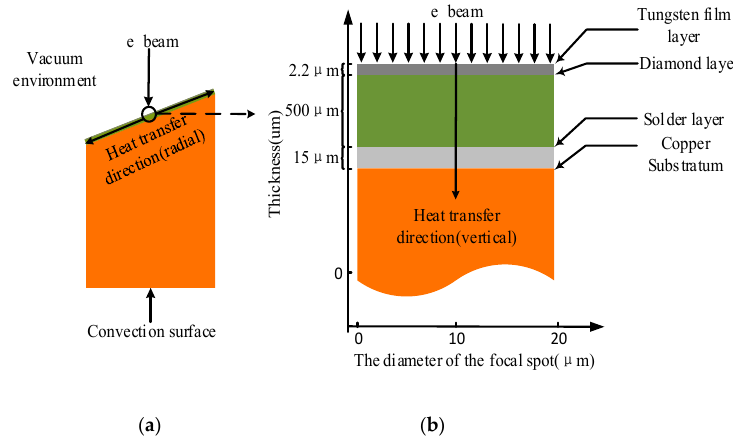
Figure 3. Two-dimensional unsteady heat transfer model of the composite anode. ( a ) Overall scheme of heat transfer of the diamond composite anode; ( b ) scheme of vertical heat transfer within the focal spot region.